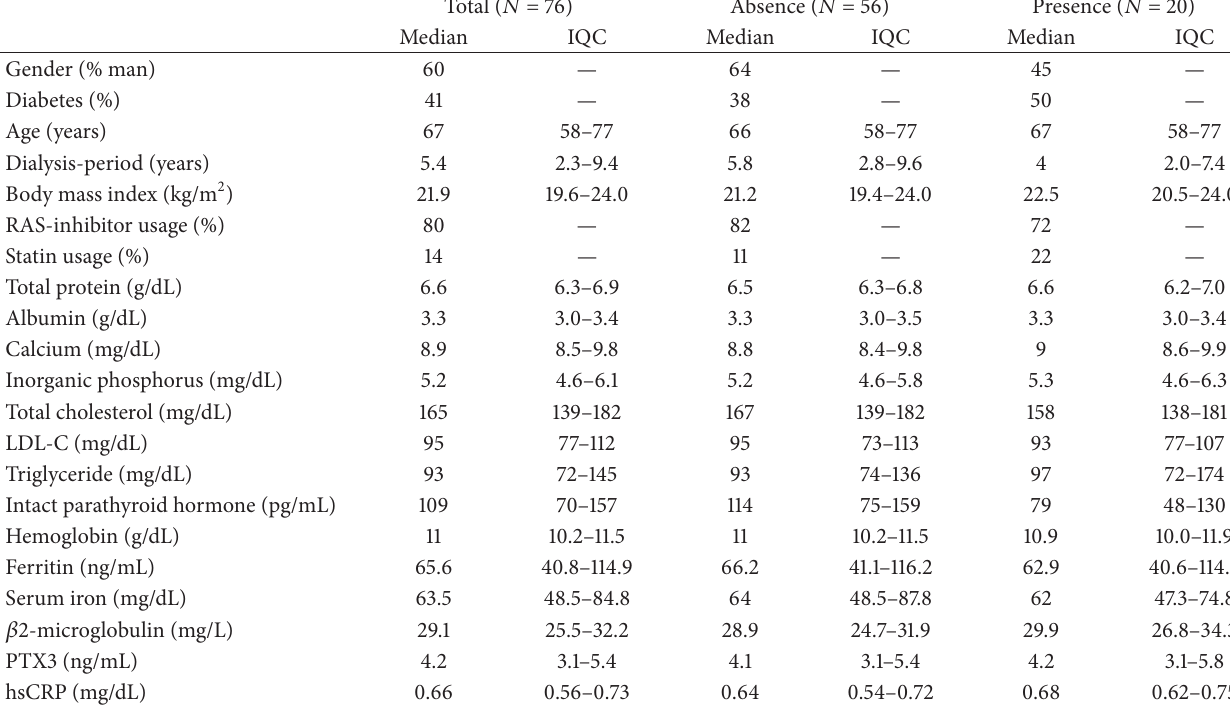
Table 1: Characteristics of the subjects with stratification by absence or presence of vascular access